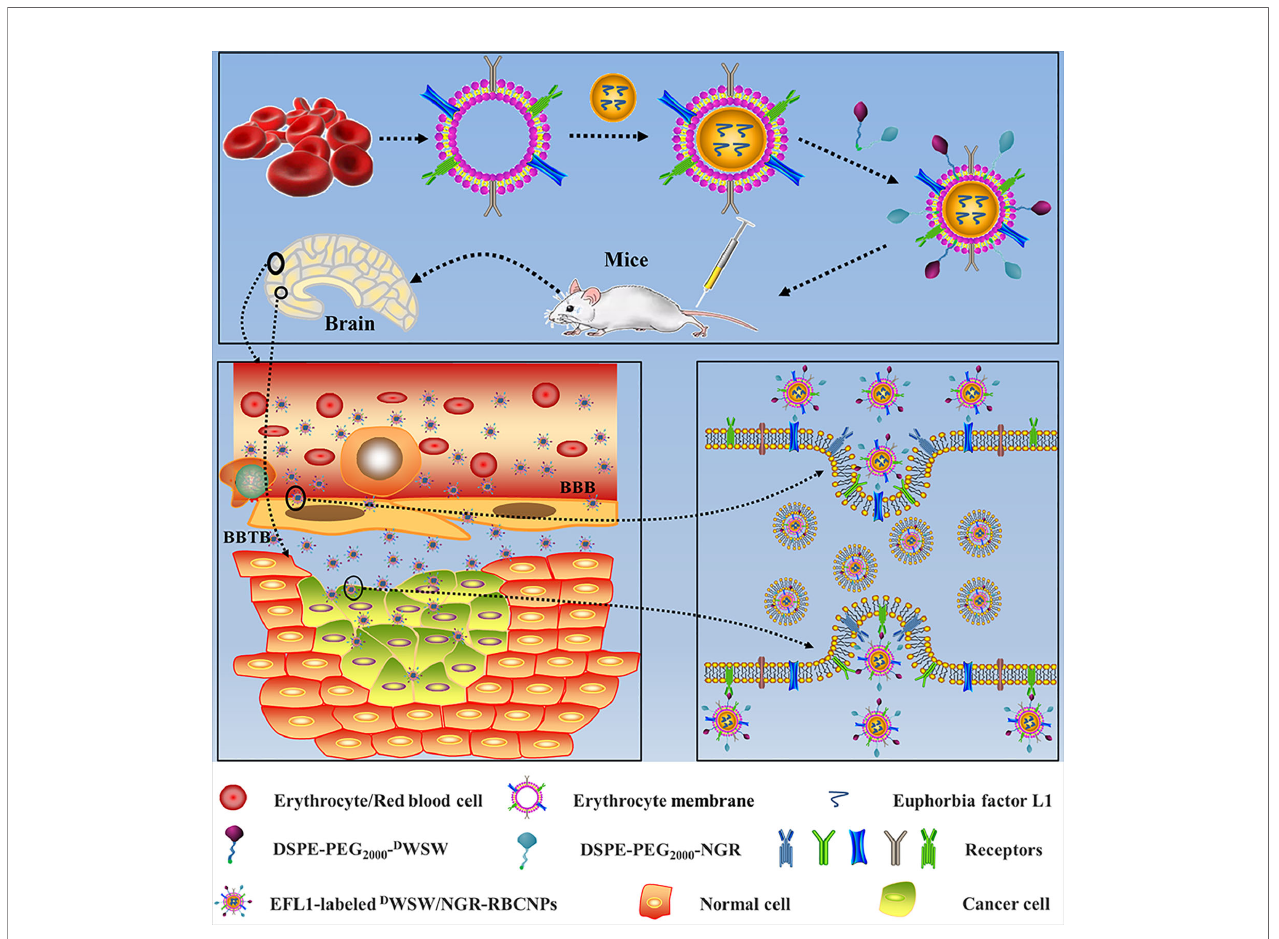
FIGURE 1 | Graphical abstract of this study. Schematic illustration of dual-target peptides modi fi ed using erythrocyte membrane-enveloped PLGA nanoparticles for the treatment of glioma. The nanoparticles were designed to penetrate the BBB and BBTB and then to aggregate at tumor sites. D WSW peptide was used to penetrate BBB and NGR was used to target tumor. D WSW/NGR-RBCNPs were observed to selectively accumulate in tumor tissue and exert a therapeutic